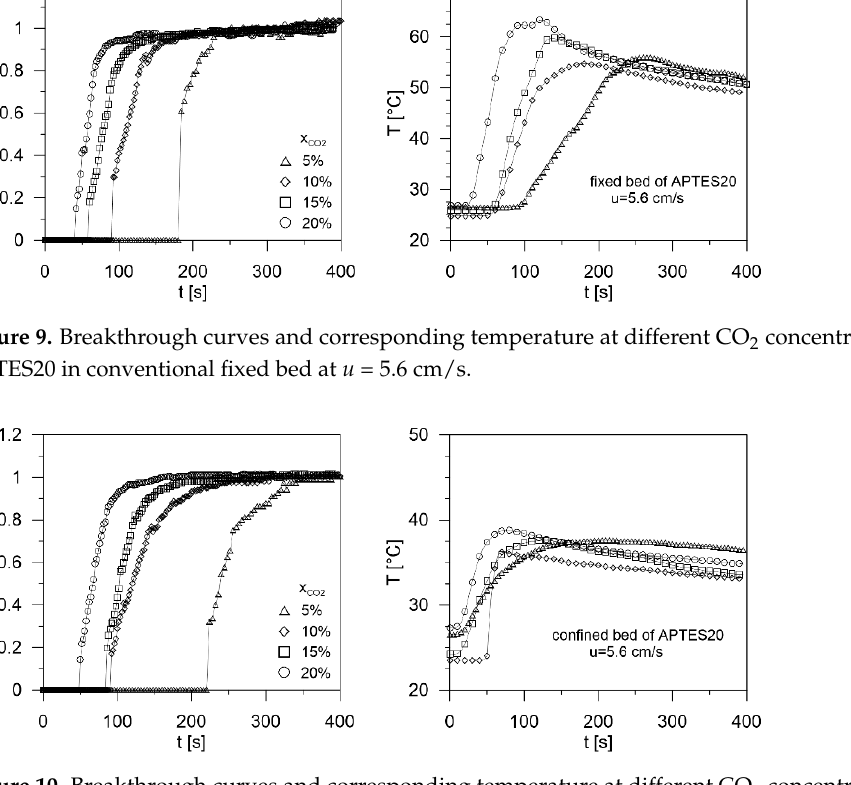
Figure 10. Breakthrough curves and corresponding temperature at different CO 2 concentrations for APTES20 in confined expanded bed at u = 5.6 cm/s.